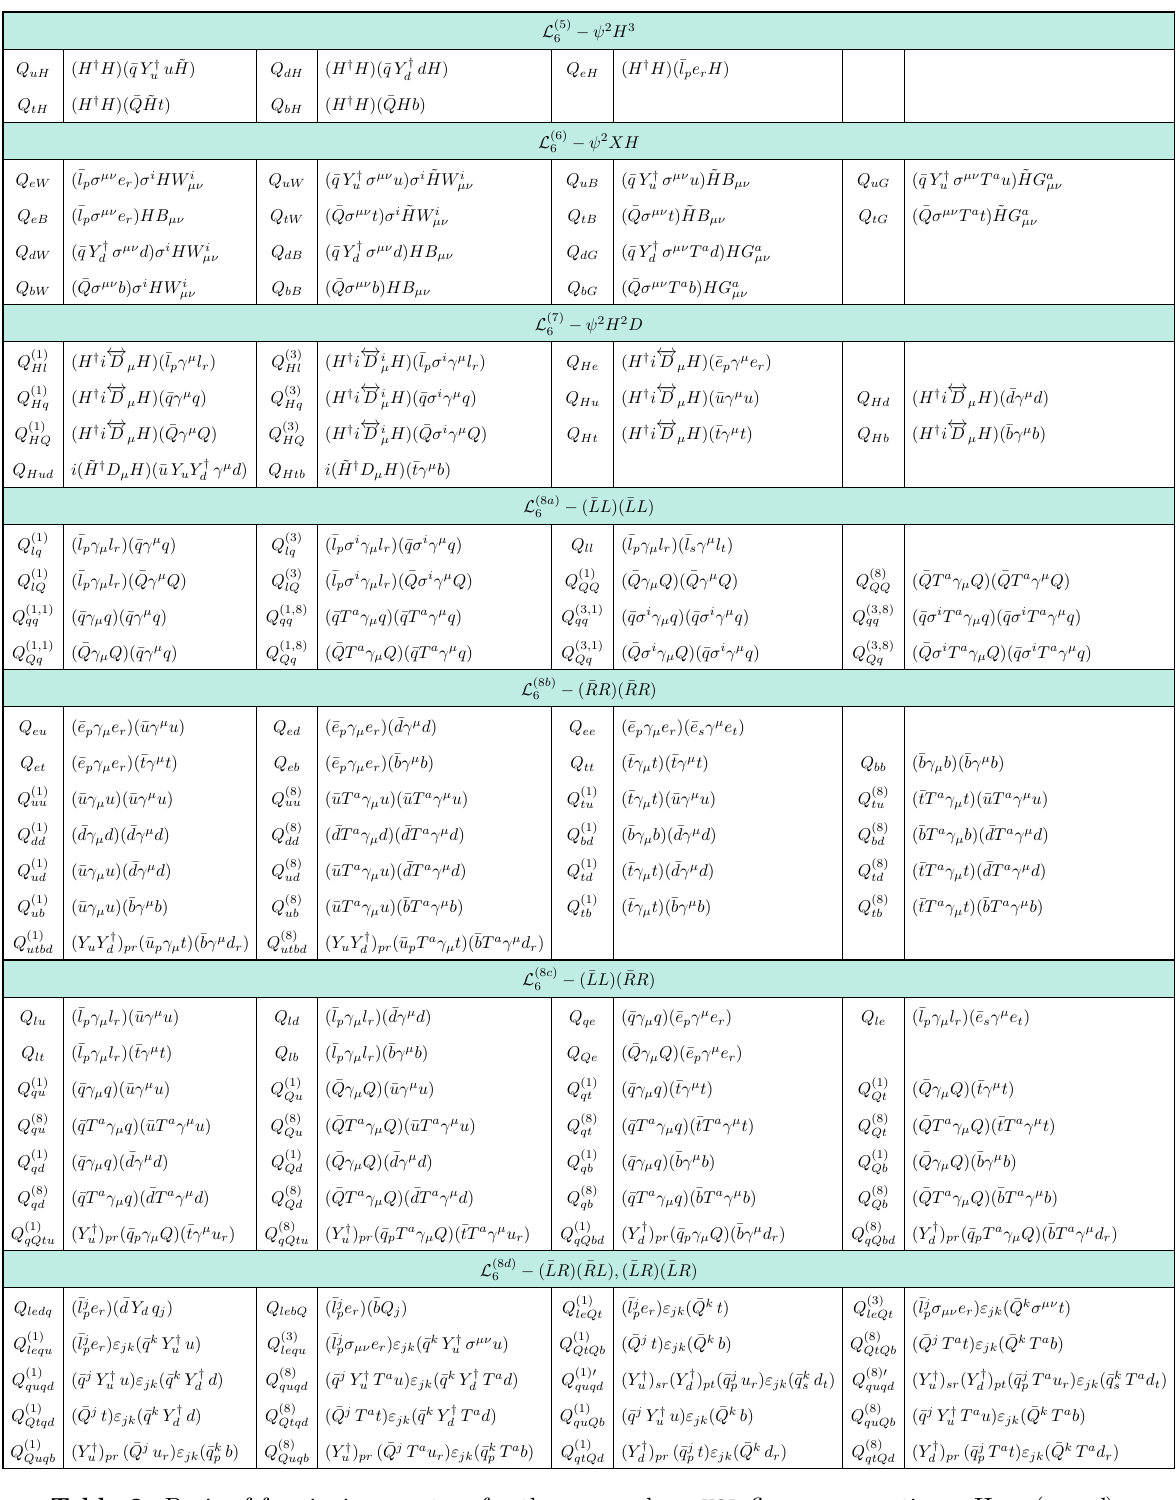
Table 2 . Basis of fermionic operators for the top and topU3l flavor assumptions. Here ( q, u, d ) , Y u , Y d denote quarks of the first 2 generations and their 2 × 2 Yukawa matrices. Quark fields of the 3rd generation are ( Q, t, b ). Flavor indices p, r, s, t run over { 1 , 2 } for light quarks and { 1 , 2 , 3 } for leptons. Whenever flavor indices are not specified, they are implicitly contracted within each